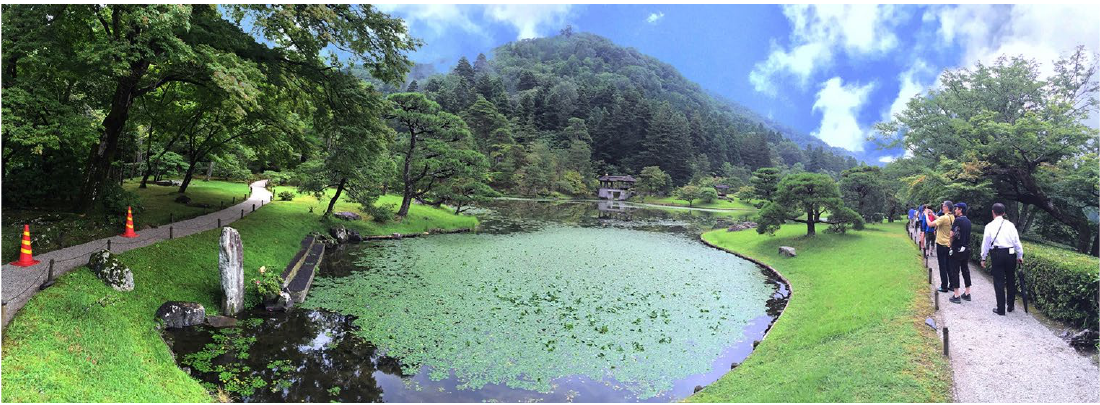
Figure 4 Shugakuin Rikyu Imperial Villa, Kyoto, Japan. (Construction: 1653-1655) (Photo by the